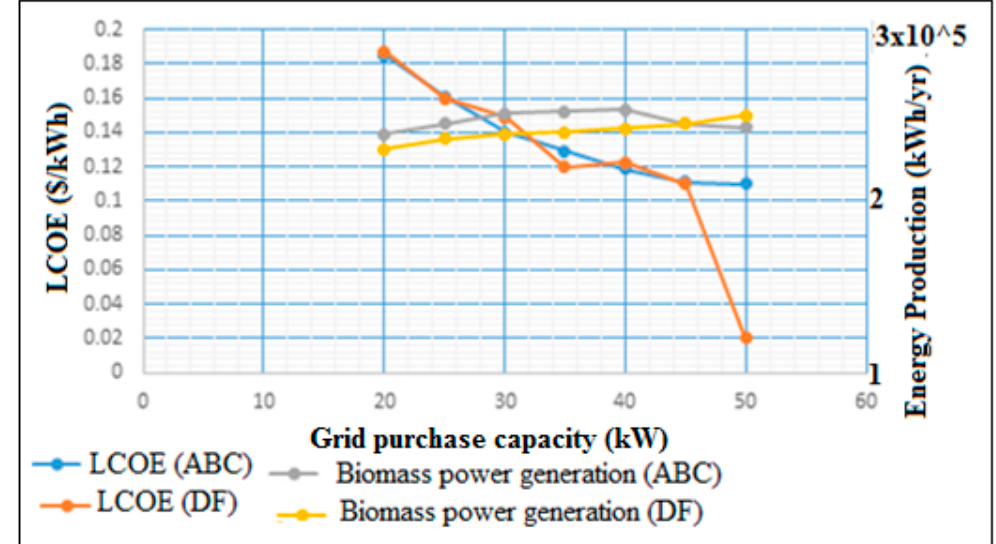
Figure 7. Comparison result of biomass power generation and levelised cost of energy (LCOE) with ABC.